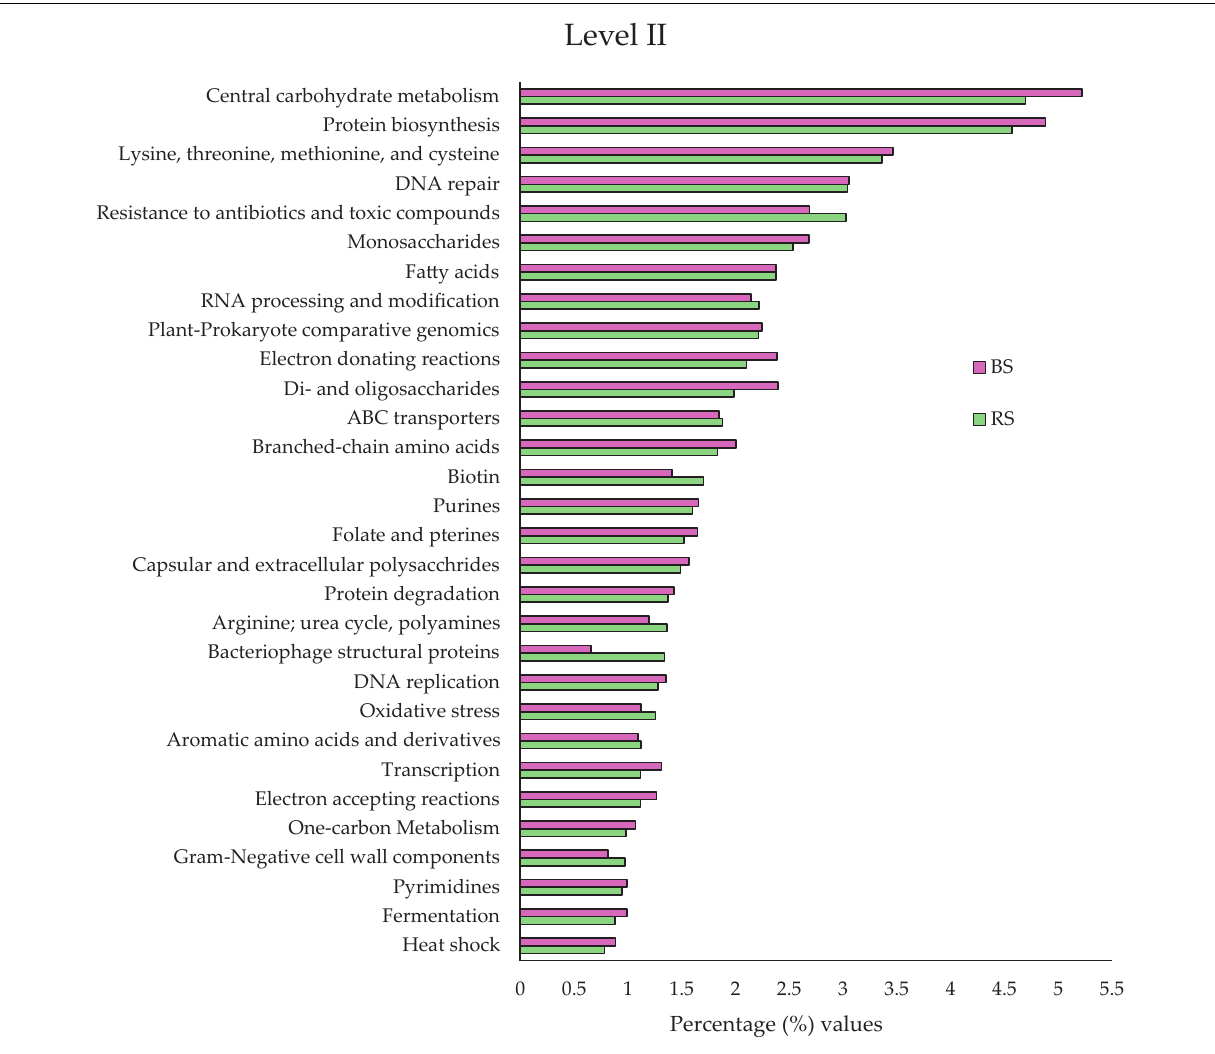
interesting because of its wide biotechnological potential. Most antibiotics and many of the compounds used in the production of medicines come from the species in this class (Hopwood,